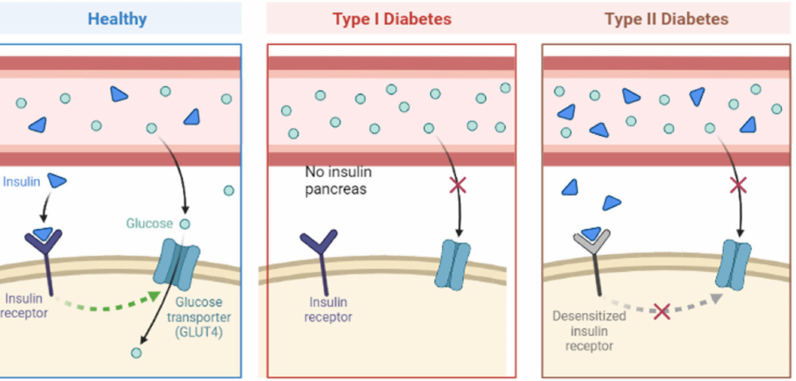
Figure 5. Schematic representation of diabetes mellitus Type I and Type II pathogenesis compared to a healthy condition. Drawn using